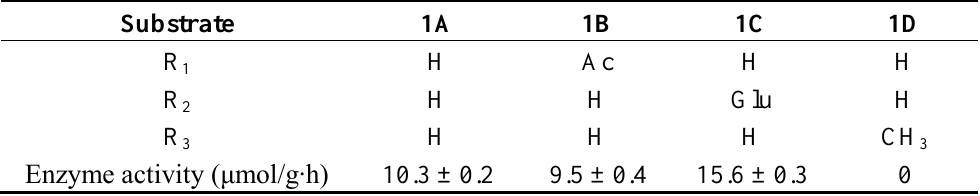
Table 3. Effect of substrate structure on the activity of immobilized